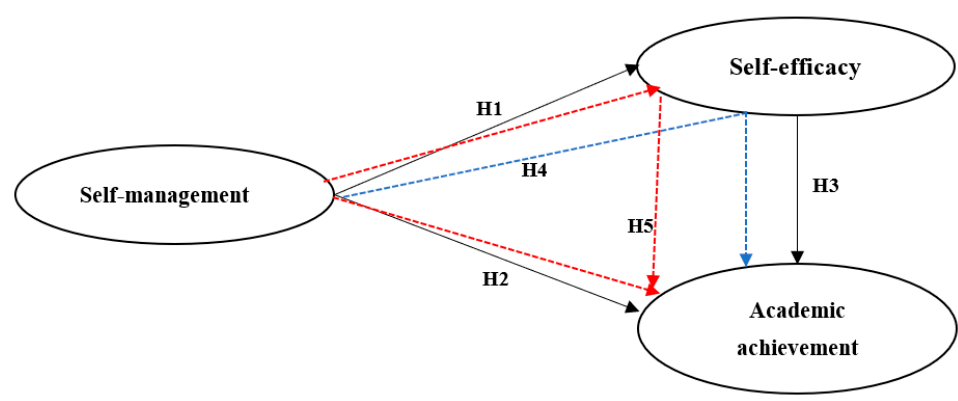
Figure 1. The research conceptual framework and hypotheses.